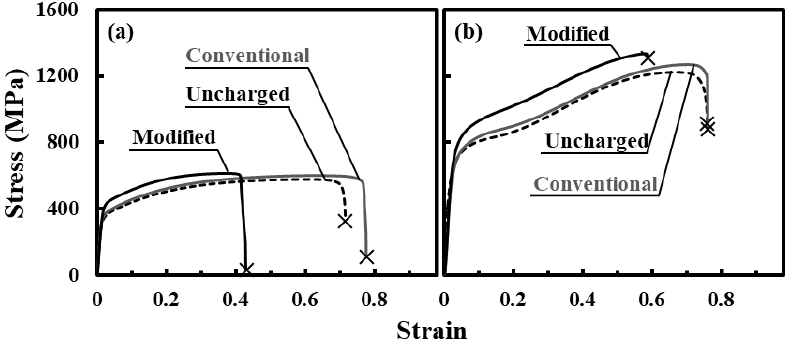
Figure 5. Representative tensile stress–strain curves obtained at ( a ) 25 °C and ( b ) −196 °C for uncharged specimen and specimen subjected to conventional and modified hydrogen charging.